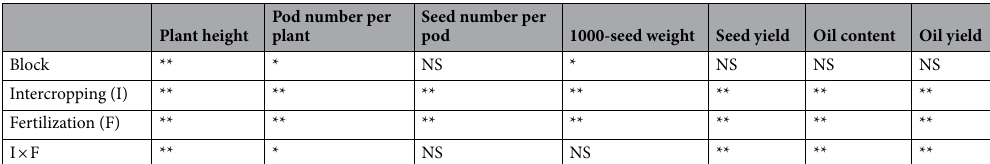
Table 6. Analysis of variance for the effects of cropping patterns and fertilization on evaluated traits in fenugreek. NS, *, and ** indicated non-significance differences and significant differences at the 5% and 1% probability levels, respectively.